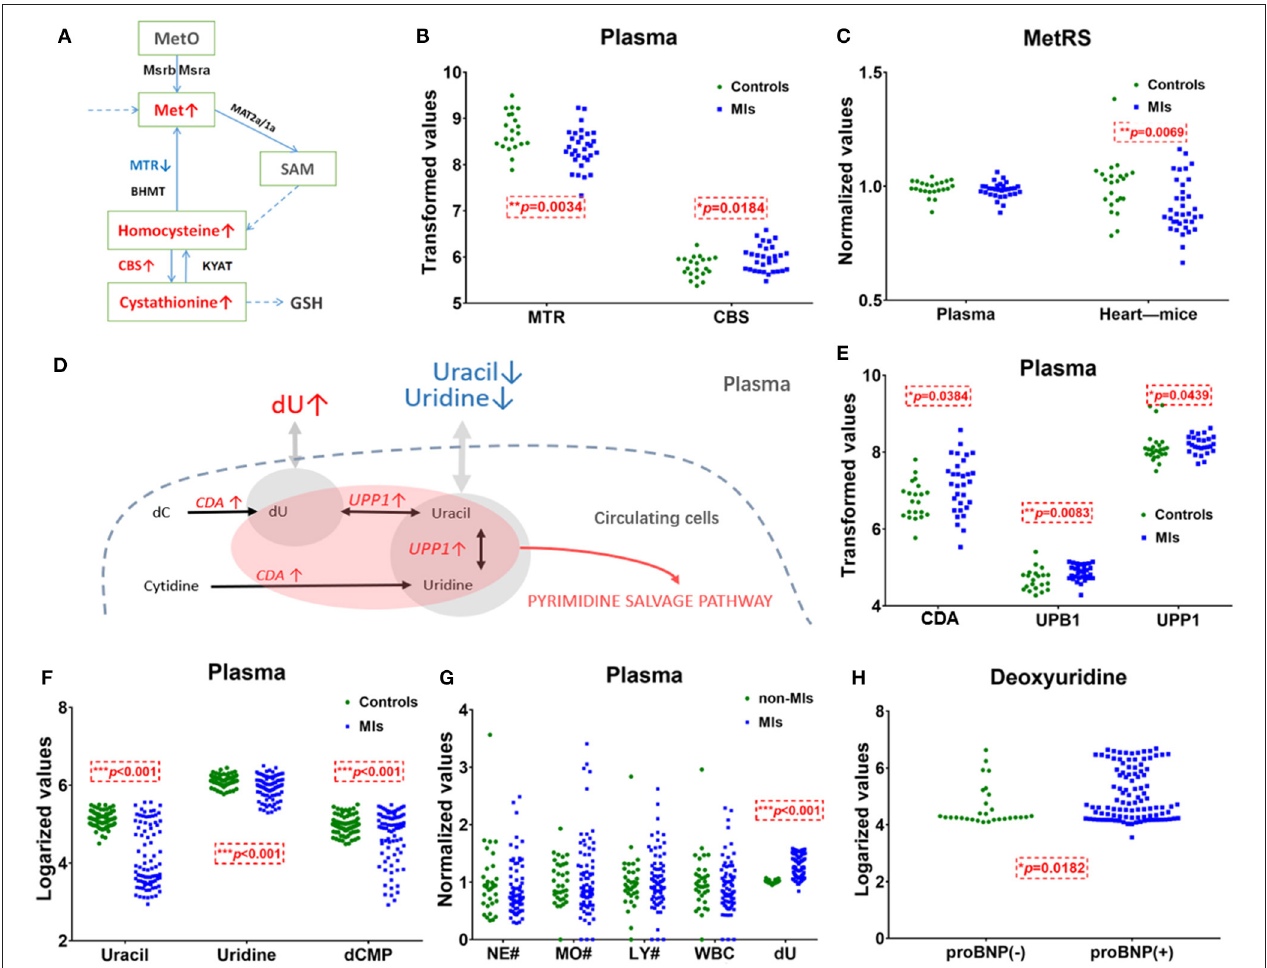
FIGURE 4 | Methionine and deoxyuridine (dU)-related pathways in plasma. (A) Methionine (Met) abundance-related pathway in plasma. (B) The Met-related enzyme MTR is significantly* decreased and CBS is significantly higher in MI cases ( n = 31) compared with healthy individuals ( n = 21). (C) The Met-related enzyme MetRS ( MARS2 ) abundance in the myocardium of murine MI models ( n = 36) is downregulated* compared with control ( n = 23), while human plasma MetRS remains unchanged. (D) dU-centered metabolism in plasma cells. (E) dU-related enzymes CDA , UPB1 , and UPP1 are significantly* higher in the MI group ( n = 31) plasma compared with those in healthy individuals ( n = 21). (F) dU-related intermediates uracil, uridine, and dCMP significantly* dropped in MI cases ( n = 85) compared with those in healthy individuals ( n = 84). (G) Neutrophils, monocytes, lymphocytes, and white cell counts of non-MI cases ( n = 34) and MI cases ( n = 74). (H) dU is significantly* higher in the NT-proBNP( + ) group ( n = 104) than in the NT-proBNP(–) group ( n = 29). (A,D) : red indicates upregulated metabolites or enzymes, blue indicates the downregulated, black indicates the unchanged, and gray indicates undetected metabolites. *Student’s t -test, p <